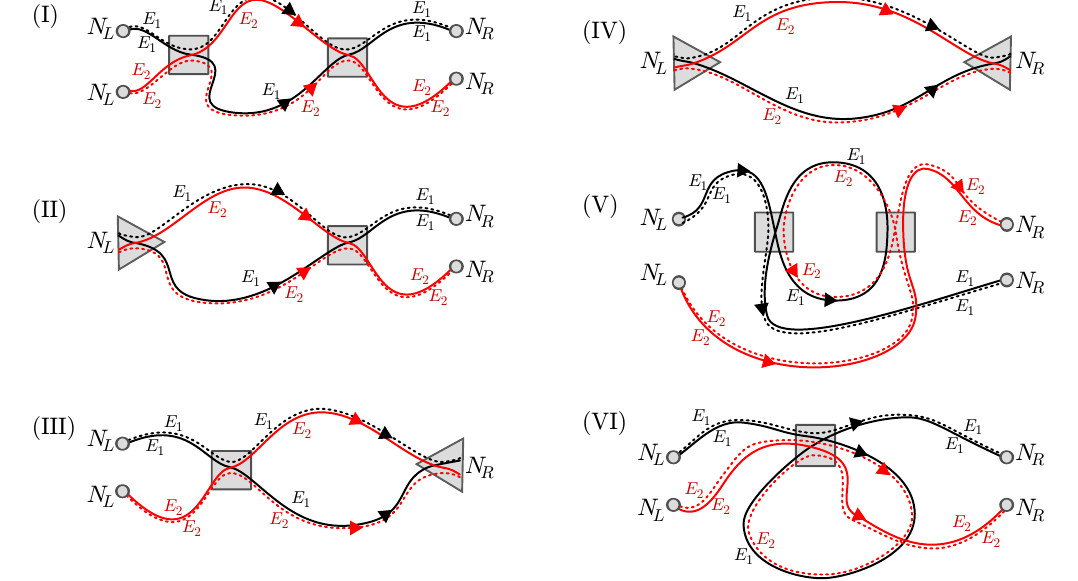
(cid:10) δ T ( ) δ T ( E ) (cid:11) without time- E Figure 5: The leading order in 1 / N contributions to 1 2 reversed trajectory-pairs; in other words, the trajectories in these contributions all go in the same direction in all trajectory pairs. These contributions are hence indepen- dent of the external B -field. The physical meaning of such contributions is indicated ) , and the in Fig. 4. The solid black trajectory correspond to a contribution to t ( E 1 ) . The solid red trajec- dashed black trajectory corresponds to contribution to t ∗ ( E 1 ) , and the dashed red one to contribution to tory correspond to a contribution to t ( E 2 ) . Triangles indicating encounters that touch the leads, and rectangles indicat- t ∗ ( E 2 ing encounters inside the system. Note that contributions II and III are only different because of how they couple to the leads. Contribution II has the four paths together in an encounter at lead L, while they are in two pairs at lead R. In contrast, contri- bution III has the paths in two pairs at lead l, while the encounter is at lead R. One must have both these